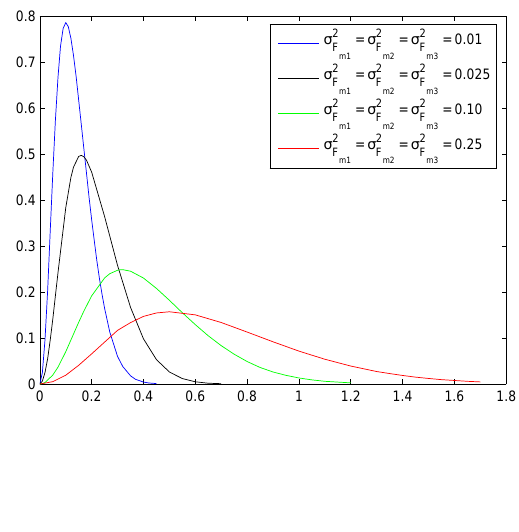
Figure 10. The distributions of random measurements with position and distance